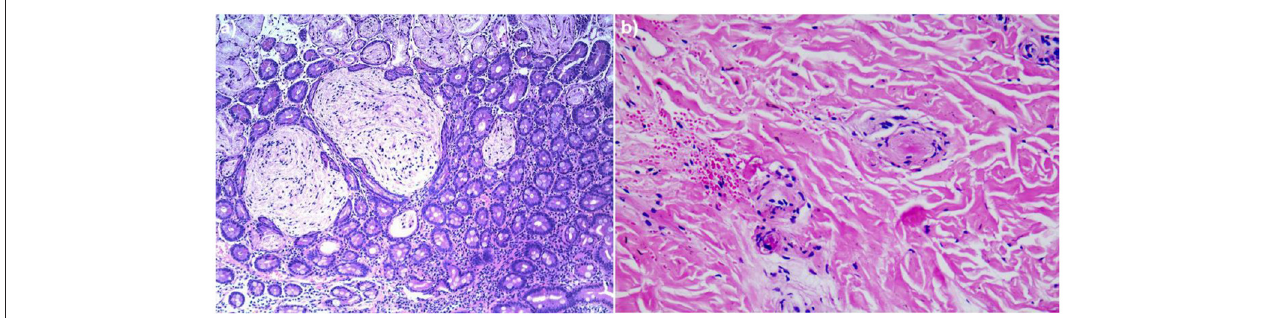
FIGURE 3 | (a) Biopsy specimen of duodenal bulb showed focal gland dilatation and inflammatory cells infiltration with focal deposits of mucin (hematoxylin and eosin, × 100). (b) Histopathologic examination of the right leg revealed thickened vascular wall with fibrinous necrosis and perivascular lymphocytes infiltration in the dermis (hematoxylin and eosin, × 200).